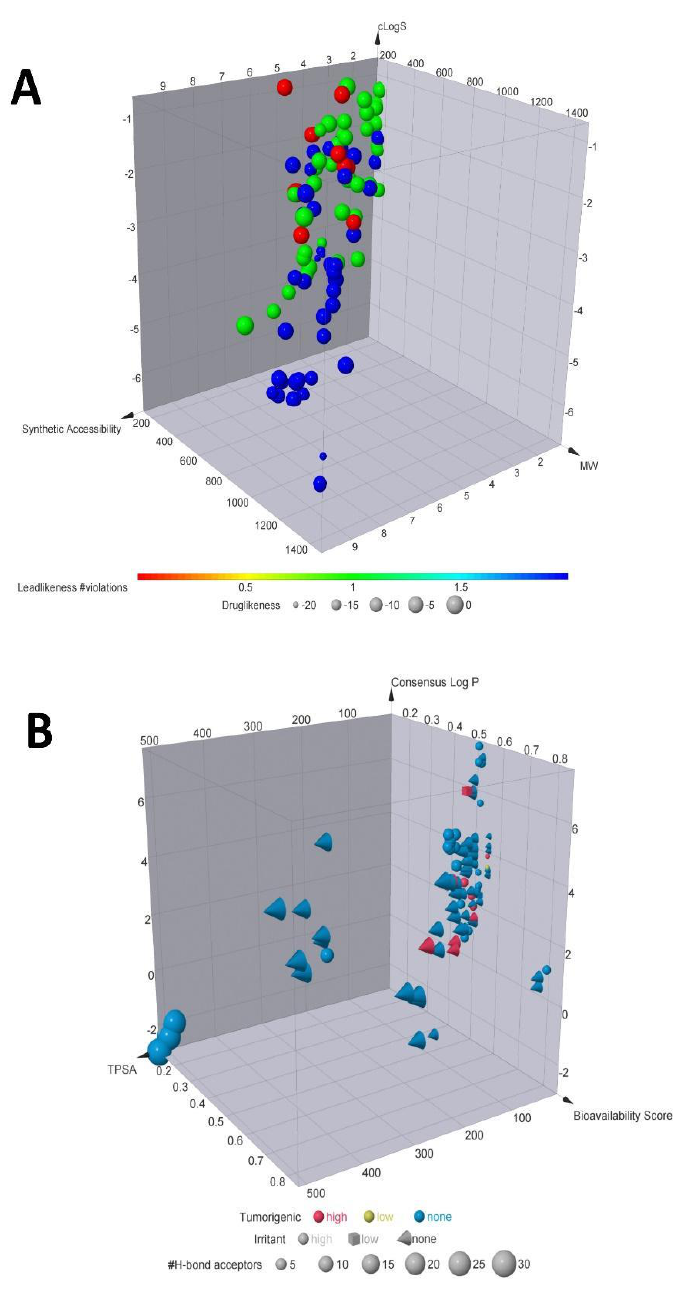
Figure 2. Chemoinformatic properties. ( A ) Molecular descriptors calculated. A selection of some of the most important properties for selected compounds. According to the color code, red dots are compounds with less leadlikeness. In contrast, the blue dots are the compounds with the significant number of leadlikeness, meaning that blue dots may be potential leaders for further analyses. ( B ) Toxicoinformatic properties. Natural products according to their properties such as tumorigenic or irritant effect, Log P, bioavailability score TPSA and H-bonds acceptors.